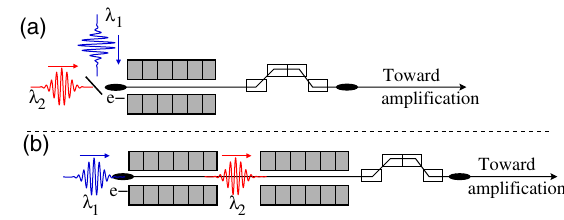
FIG. 1. Layout of the frequency mixing process. First step: interaction between an electron-bunch and two external laser pulses of wavelength λ 1 and λ 2 , in (a) one or (b) two undulators. Second step: passage of the electrons through a dispersive section (composed of three bending magnets). The induced micro- structurescanthen beusedto startlight amplification inundulators.